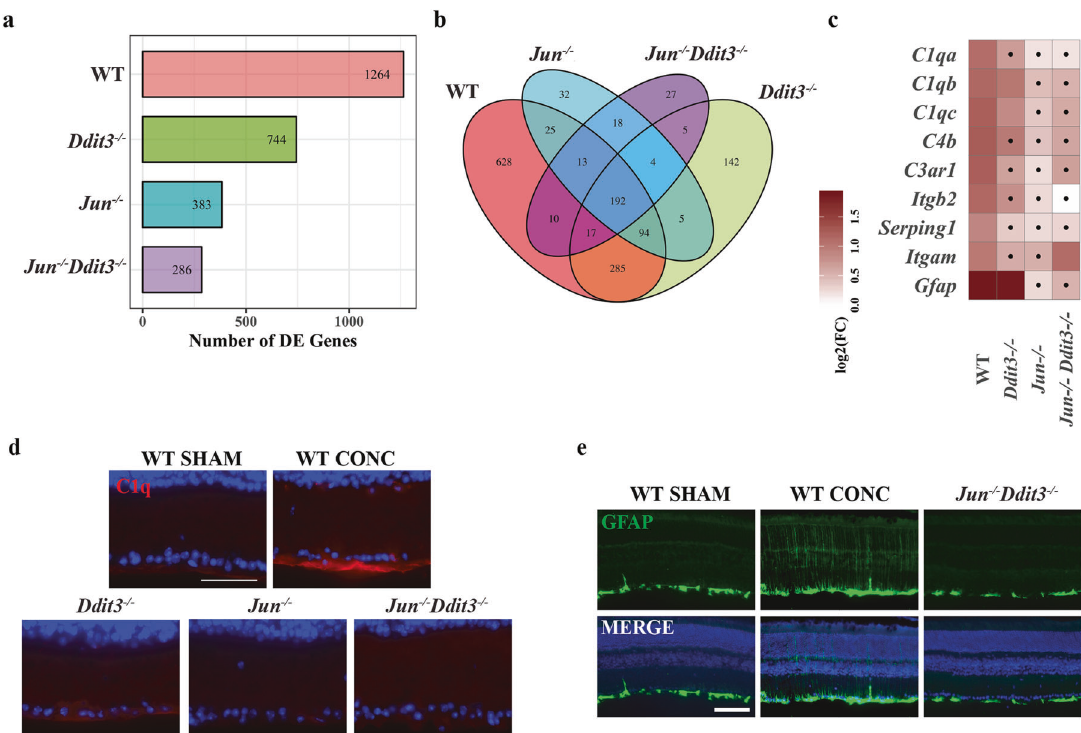
Fig. 1 Axonal injury altered the transcription of neuroin fl ammatory pathways in retinal tissue. CONC led to differential expression of genes in wildtype (WT), Ddit3 ( Ddit3 − / − ) , Jun ( Jun − / − ) , and dual Jun/Ddit3 ( Jun − / − Ddit3 − / − ) de fi cient retinas ( a ). Venn diagram depicting the overlap of CONC-responding DE genes in all experimental groups ( b ). Expression of in fl ammatory signaling genes including complement genes and Gfap in WT, Jun , Ddit3 , and dual Jun/Ddit3 de fi cient retinas after CONC as compared to unmanipulated retinas ( c ). Area marked with a dot indicates the fold change of a gene is not signi fi cant (FDR ≥ 0.05) in a given genotype group. Area without a dot indicates the fold change of a gene is signi fi cant (FDR < 0.05) in a given genotype group. To validate the gene expression data, retinal sections were stained for C1QA and counterstained with DAPI to assess complement signaling after axonal injury. C1QA immuno fl uorescence was increased after axonal injury in the retinal nerve fi ber layer and inner plexiform layer in WT animals after CONC injury as compared to sham retinas, however, these changes were not observed in Jun , Ddit3 , or dual Jun/Ddit3 de fi cient retinas after CONC ( d N = 3 per genotype; Scale bar: 50 μ m). Gfap expression was also increased in WT animals but not Jun de fi cient or dual Jun/Ddit3 de fi cient retinas after CONC as compared to unmanipulated retinas ( c ). Retinal sections were stained for GFAP and counterstained with DAPI after axonal injury. GFAP + presumed Müller glial processes were evident after axonal injury in WT animals as compared to sham retinas, however, these changes were not observed